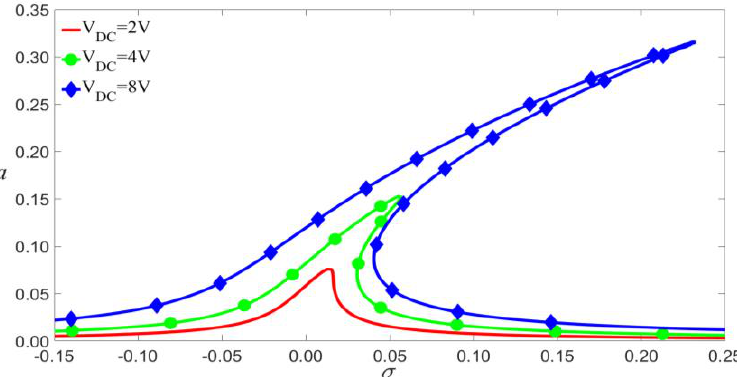
Figure 13. Comparison in amplitude of the response as a function of the load’s amplitude by con- sidering different nonlinear damping terms.